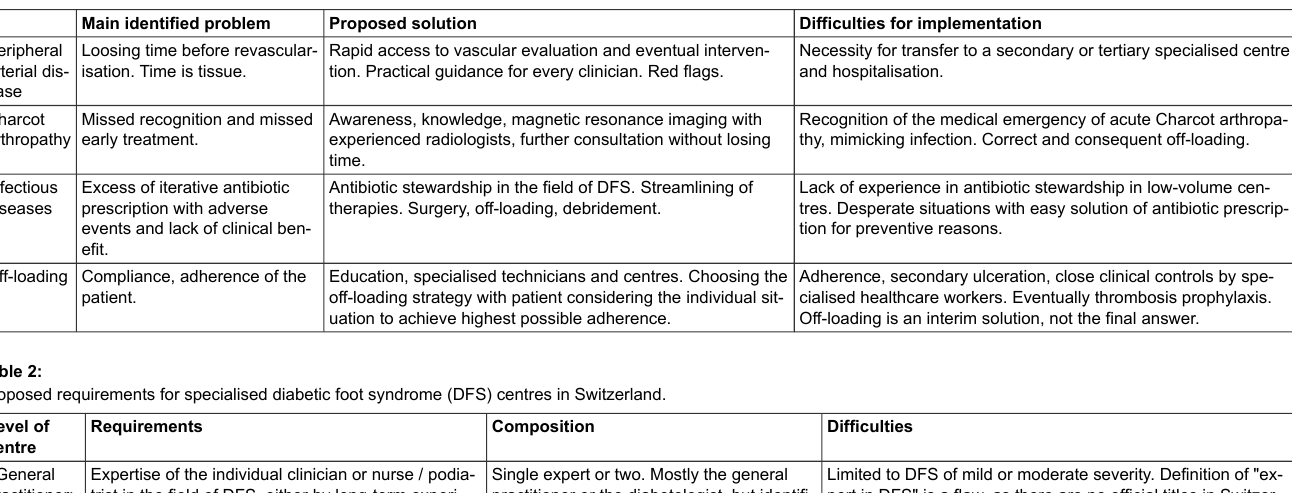
Table 1: Examples of information in the proposed Swiss guidance on diabetic foot syndrome (DFS)- stratified by the most important key messages. Main identified problem